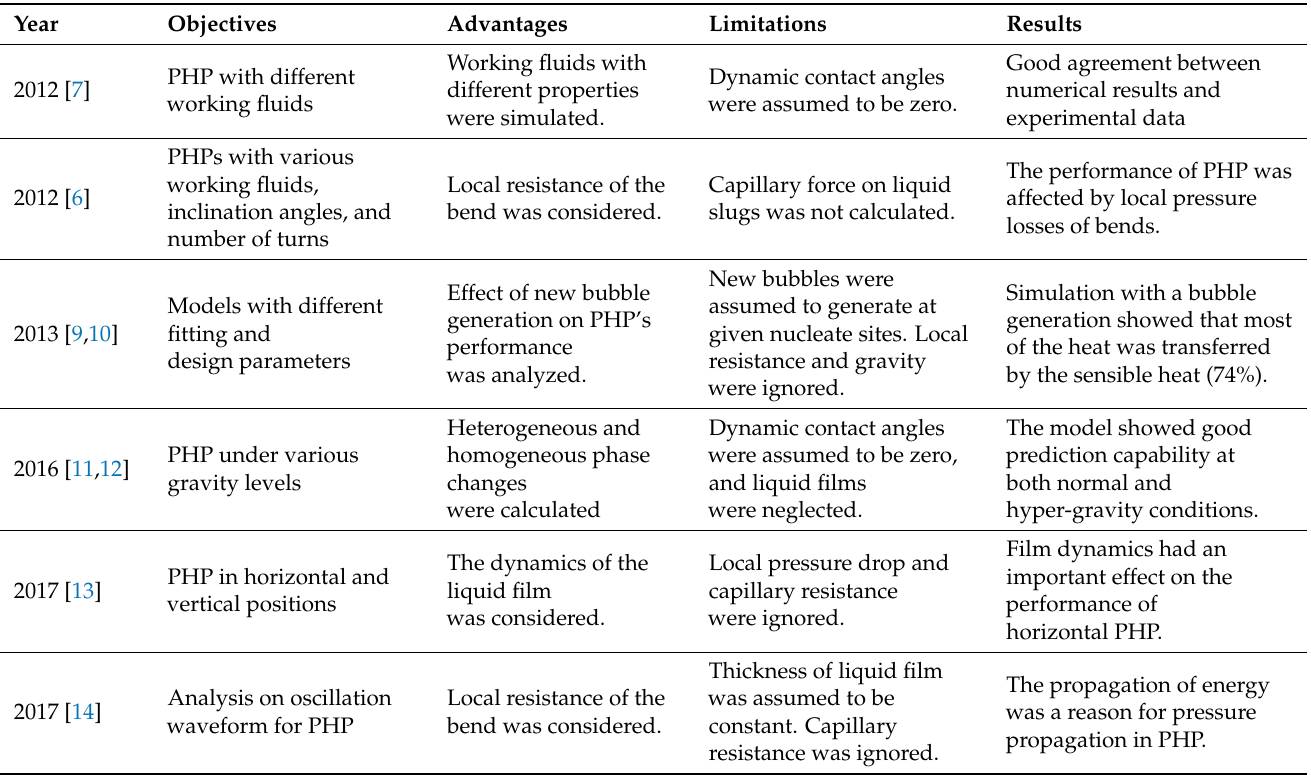
Table 1. Typical numerical models in recent 10